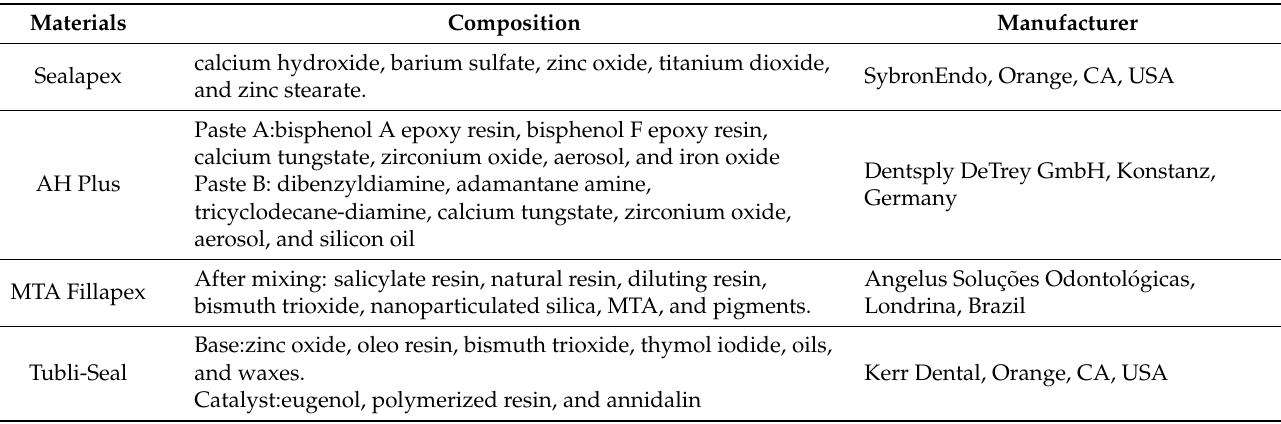
Table 1. Root canal sealers used in the present